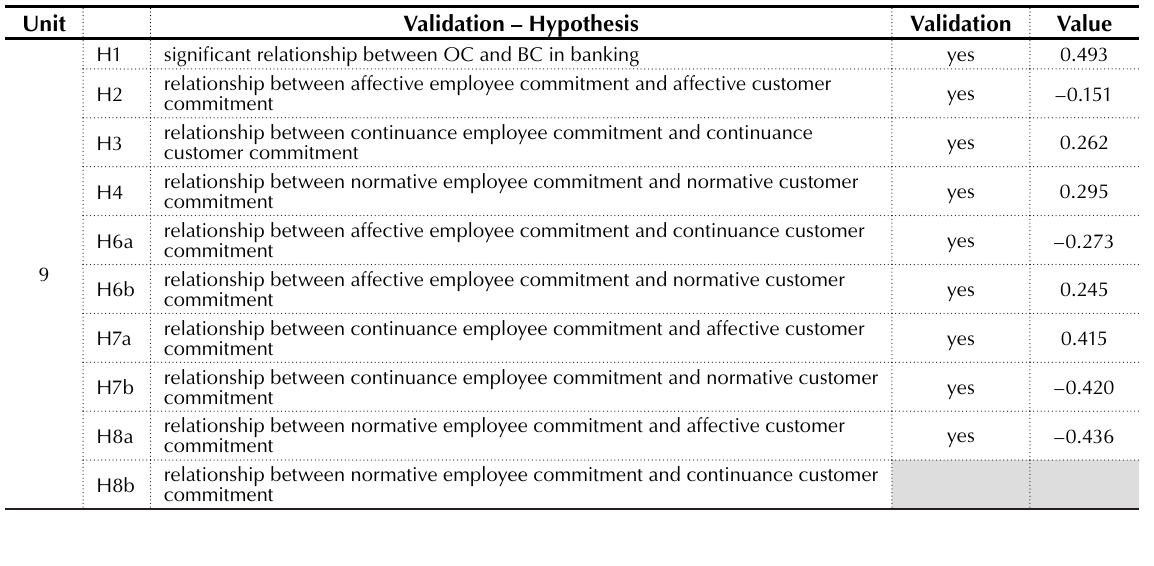
Table 2: Hypotheses validation for unit 5